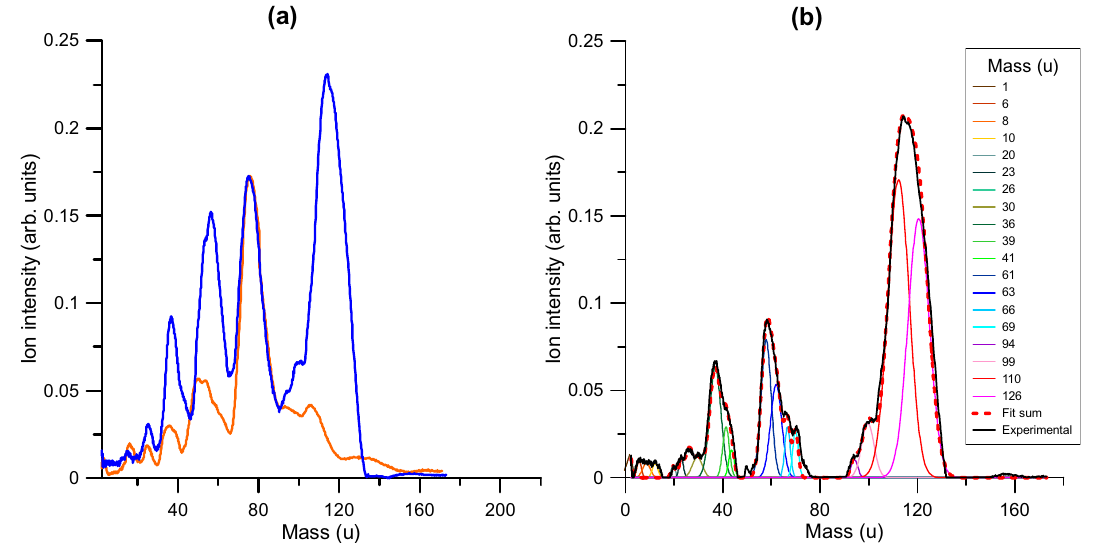
Figure 3. Positive ion spectra. ( a ) cationic fragmentation induced by the electron beam ( ― ) and the negative ion ( ― ) impact. ( b ) mass analysis (Gaussian function fitting) of the positive ion pattern obtained by subtracting the electron impact spectrum from that of the negative ion